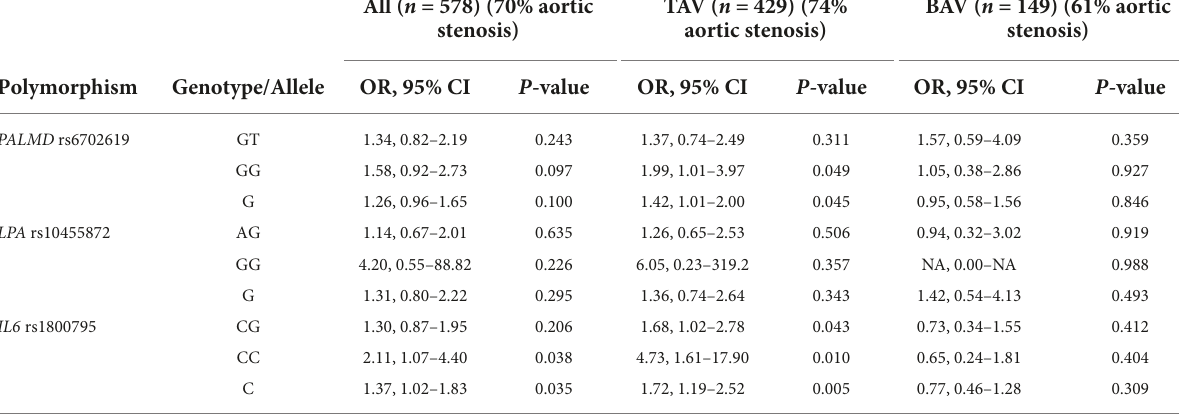
TABLE 2 Association between polymorphisms and aortic stenosis according to aortic valve morphology.